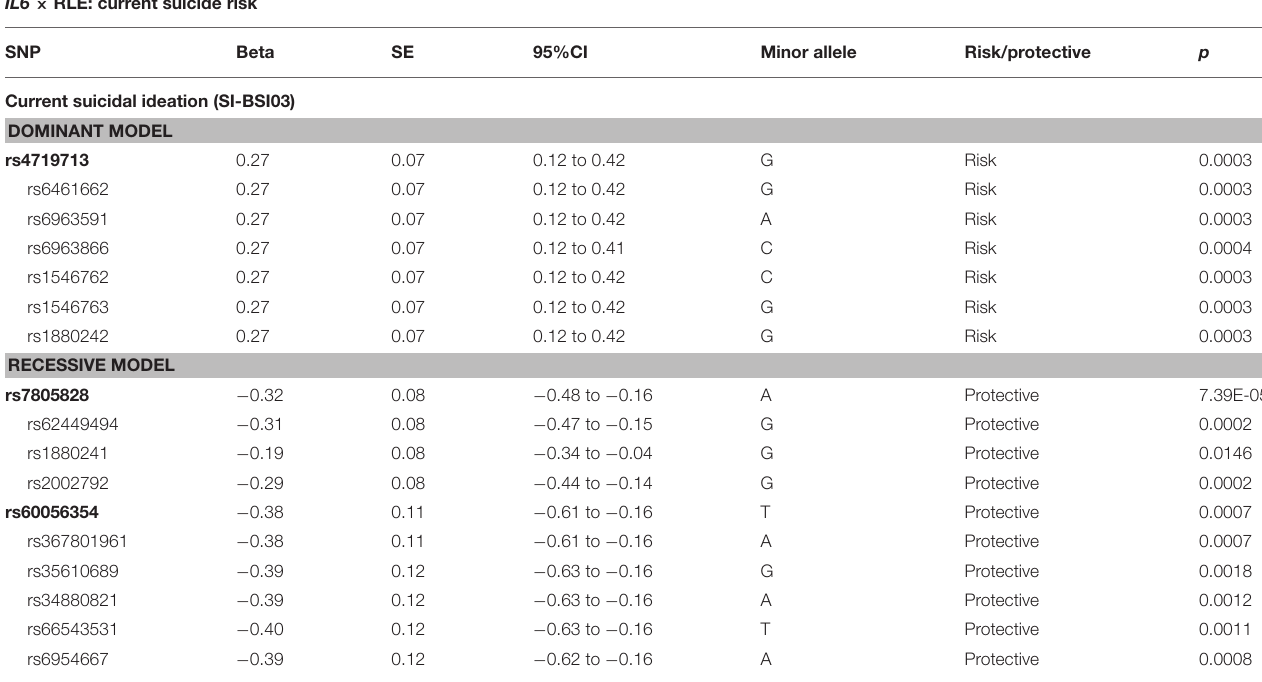
TABLE 5 | Interaction effects of IL6 variation and recent negative life events on current markers of suicidality. IL6 × RLE: current suicide